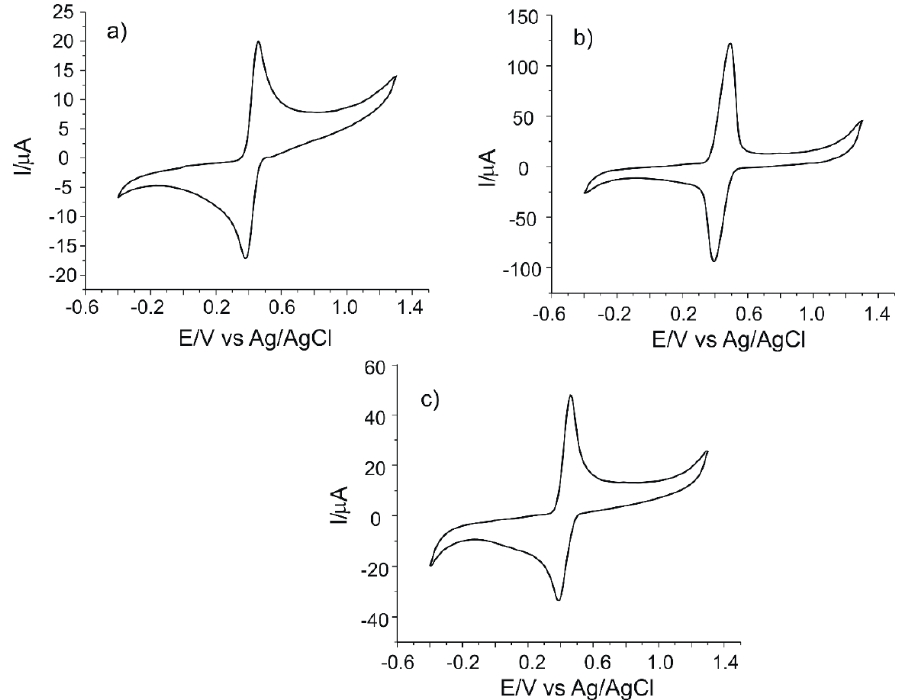
Figure 3. Cyclic voltammograms of ( a ) C-SPE, ( b ) CNF/C-SPE and ( c ) MWCNT/C-SPE immersed in 10 − 3 M caffeic acid solution (support electrolyte 0.1 M PBS, pH = 3.6).